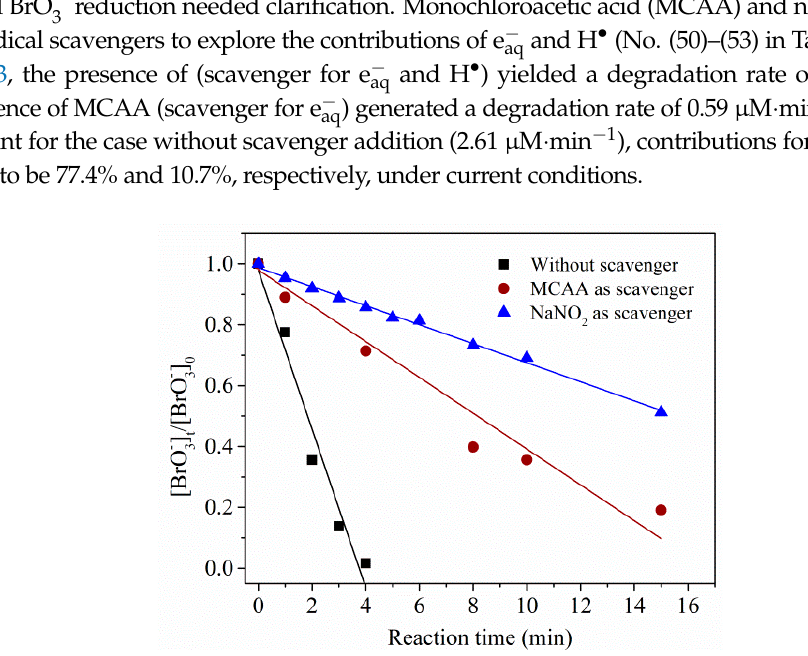
Figure 2. Efficiencies of BrO − degradation using UV/sulfite/I − in real water. Conditions: [BrO − 3 ] 0 = 10 μ M, [ I (cid:2879) ] 0 = 100 μ M, [sulfite] 0 = 1.0 mM, UV dosage = 231.38 mJ·cm − 2 .